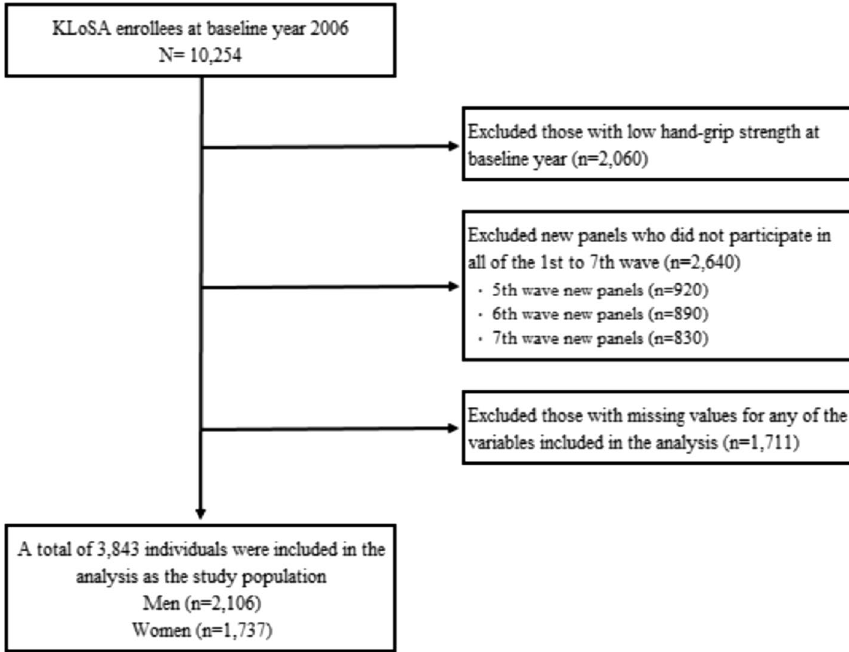
Figure 1. Flow chart of sample